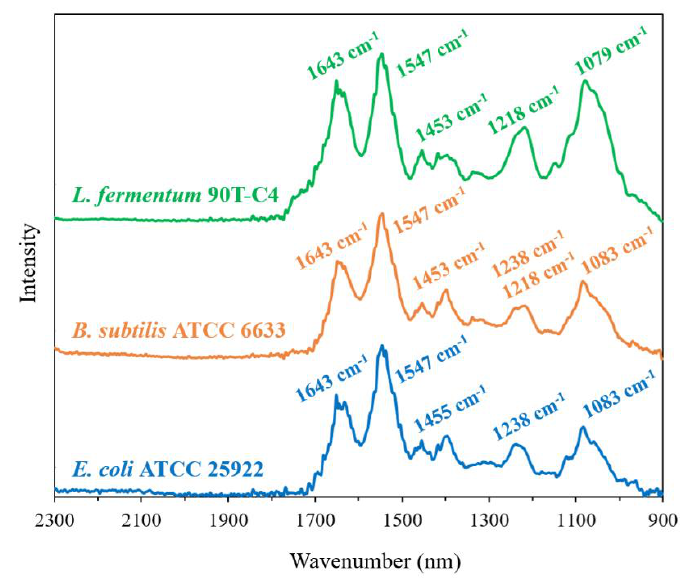
Figure 5. FTIR spectra of L. fermentum 90T-C4, B. subtilis ATCC6633 and E. coli ATCC 25922 in the range 2300 – 900 cm −1 of pure cultures of bacteria, ~10 11 CFU/mL, H 2 O, 22 ᴼ C.